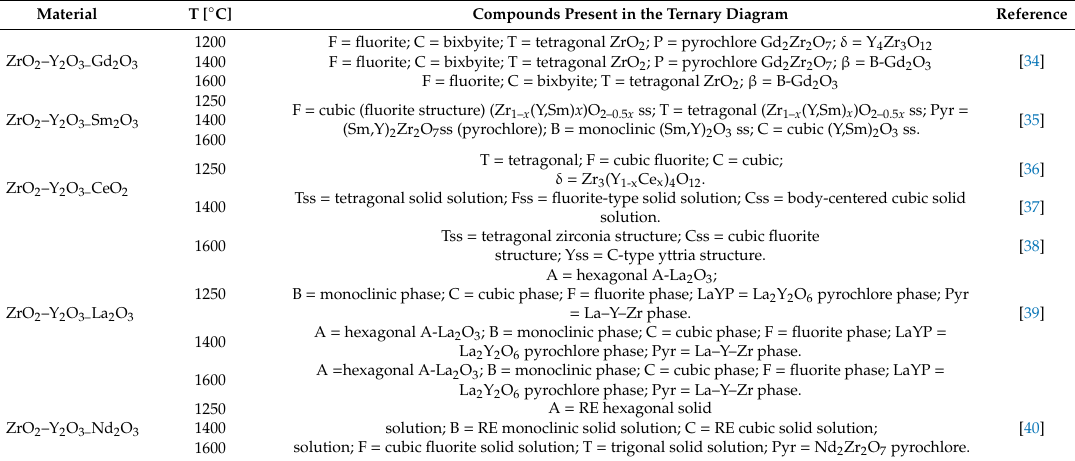
Table 4. Equilibrium compounds in the ternary diagrams ZrO 2 –Y 2 O 3 –Ln 2 O 3 (where Ln = Gd 2 O 3 , Sm 2 O 3 , CeO 2 , La 2 O 3 , and Nd 2 O 3